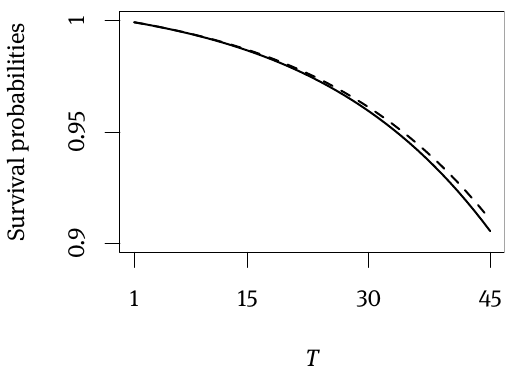
Figure 3: Initial term structure of survival probabilities under the real-world probability measure P (solid line) and the risk- neutral measure Q (dashed